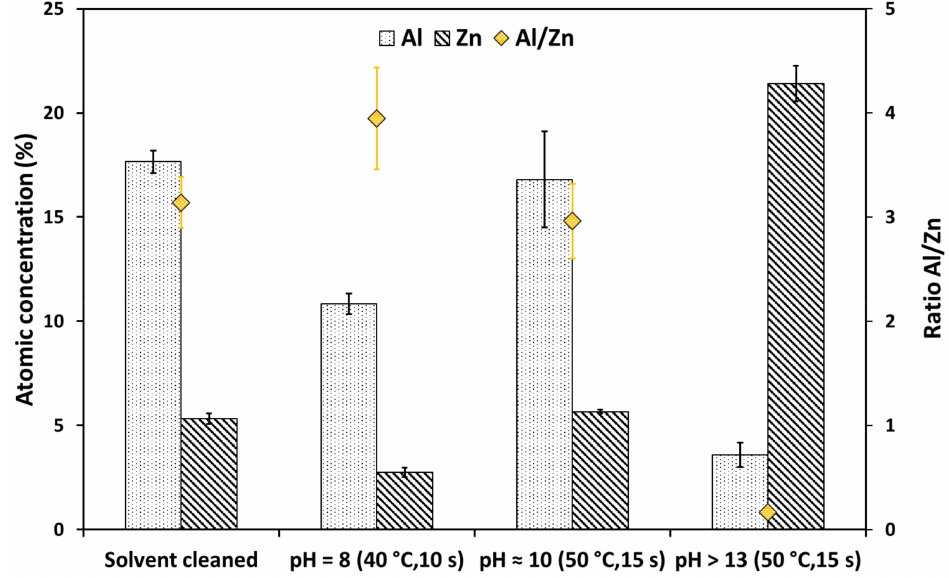
Figure 5. Atomic concentration of aluminum and zinc obtained by XPS on a bare HDG steel after solvent cleaning and alkaline cleaning. The ratio Al/Zn is also